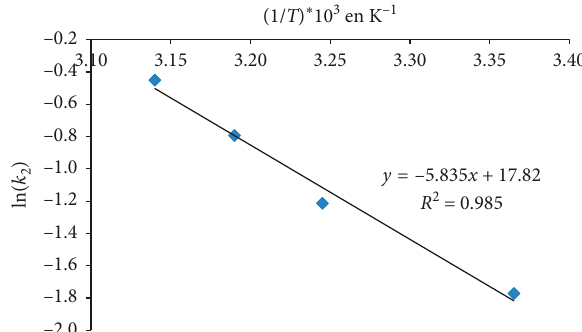
Figure 10: Representation of ln( k